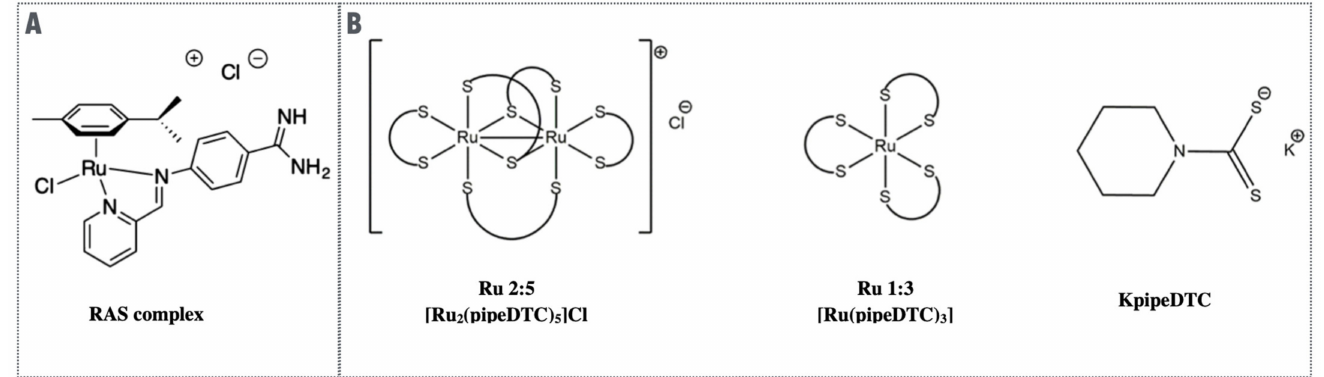
Figure 7. ( A ). Ruthenium complexes with piano-stool structure. ( B ). Ruthenium complexes with bond to sulfur. Ru 2:5 and Ru 1:3 were synthesized using the ligand K pipeDTC represented on the right. All these complexes can induce the ER stress